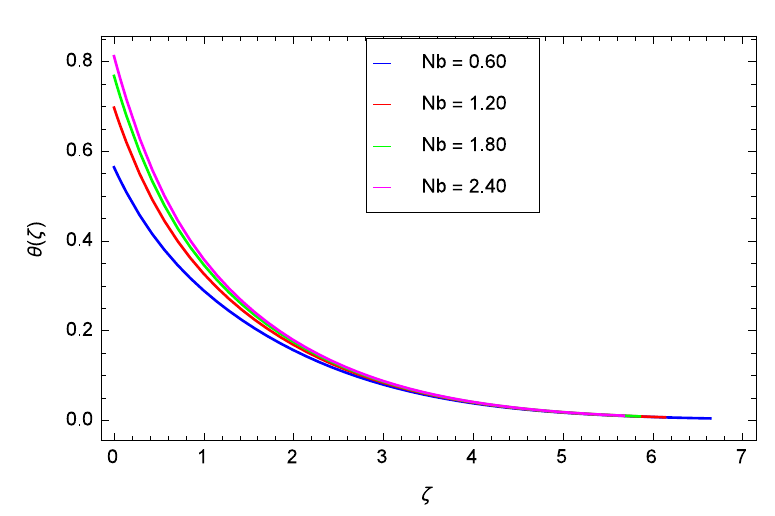
Figure 13. Influence of Nt on θ ( ζ ) .